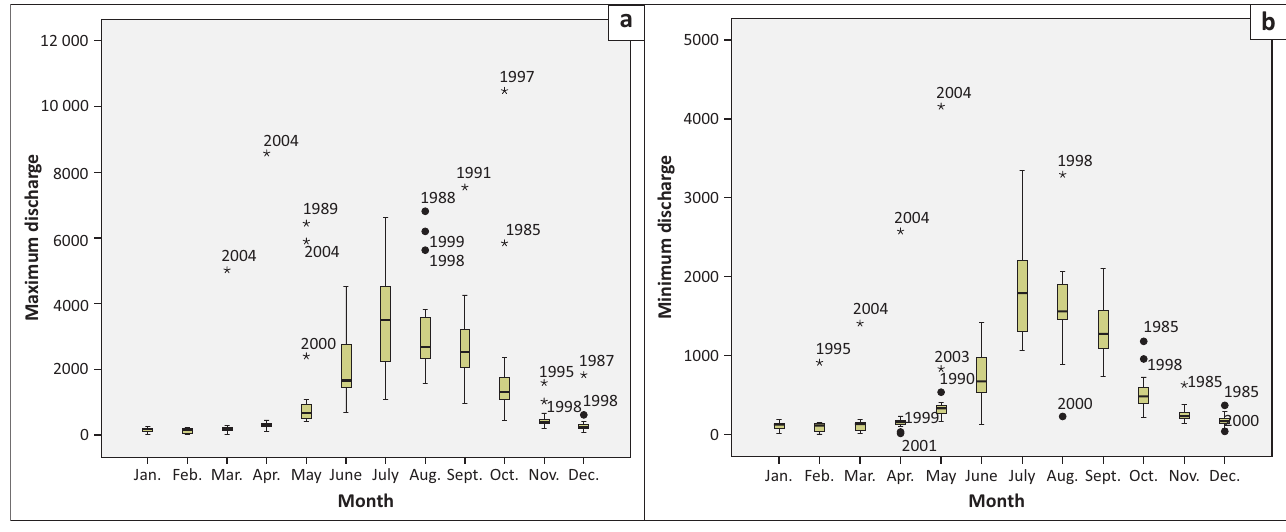
FIGURE 1: Monthly (a) maximum discharge and (b) minimum discharge at Kaunia from 1985 to 2006.